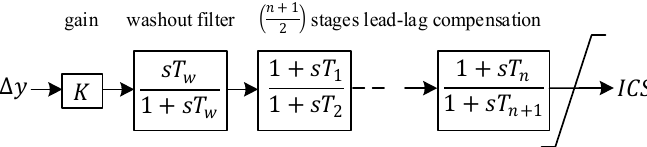
Figure 10. Control structure of a generic supplementary controller.